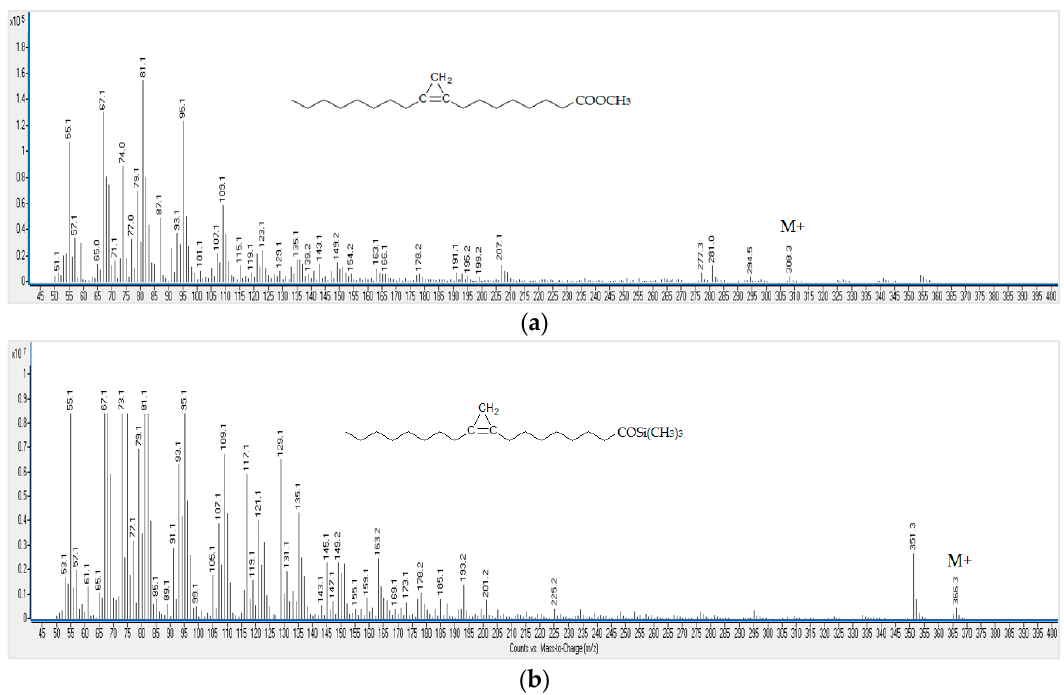
Figure 1. ( a ) Mass spectrum and chemical formula of sterculic acid methyl ester (M + : m / z 308); ( b ) Mass spectrum and chemical formula of sterculic acid silyl ether (M + : m / z 366). Regarding the GC-MS analysis of sterculic acid after acid methylation, it shows a molecular ion (M + ) at m/z 308. Different signals were also detected, including some degradation products and arte- facts (probably polymers) (Figure 2).